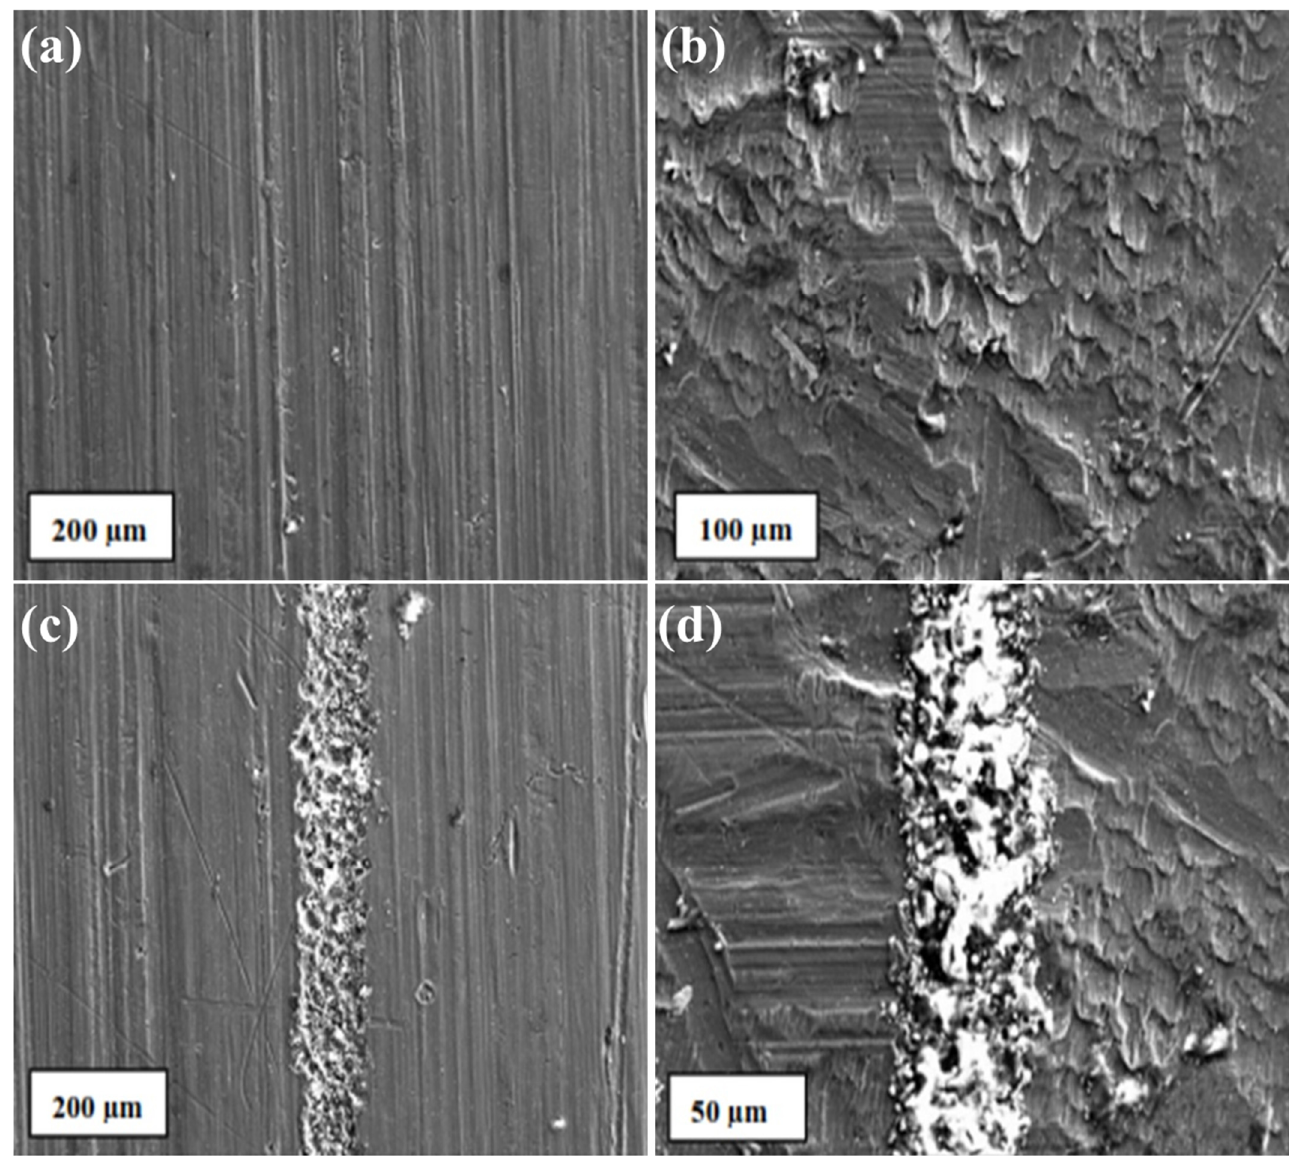
Figure 13. SEM images of weld zone of Al-MMC: ( a ) base material, ( b ) initial stage, ( c ) progressive stage, ( d ) advanced stage.